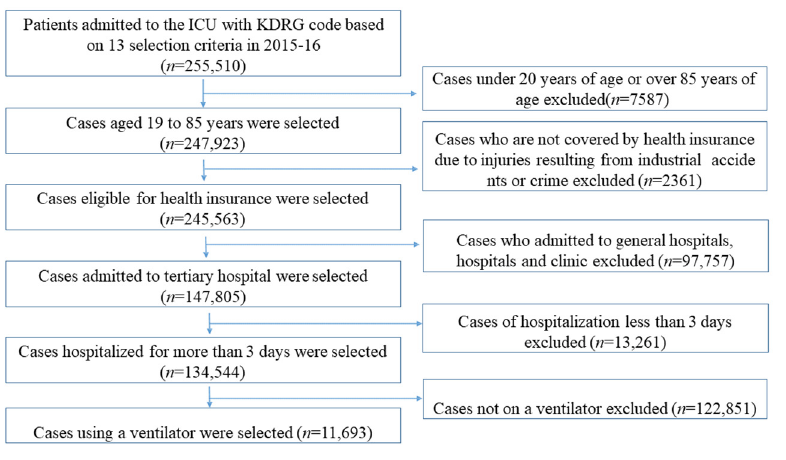
Figure 1. Data extraction flow.